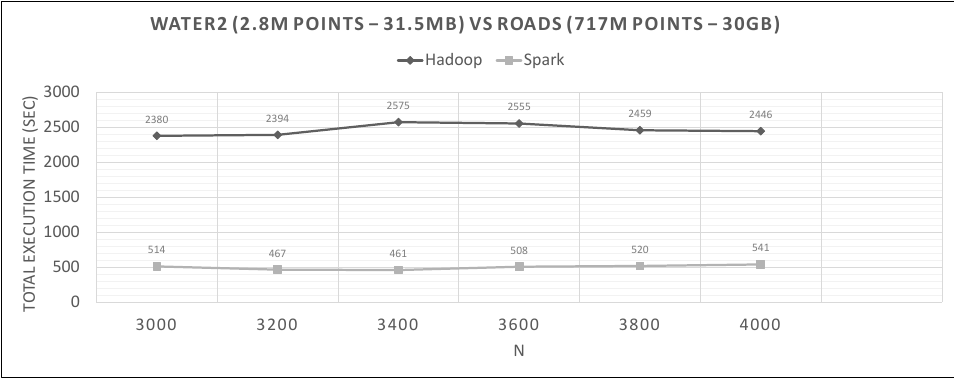
Figure 27. Hadoop vs. Spark, hydro (new loc.) query and large training datasets.